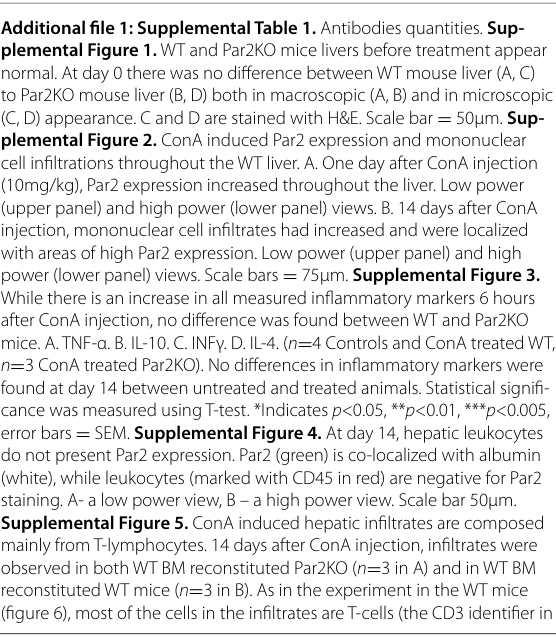
SEM. Supplemental Figure 4. At day 14, hepatic leukocytes = do not present Par2 expression. Par2 (green) is co-localized with albumin (white), while leukocytes (marked with CD45 in red) are negative for Par2 staining. A- a low power view, B – a high power view. Scale bar 50μm. Supplemental Figure 5. ConA induced hepatic infiltrates are composed mainly from T-lymphocytes. 14 days after ConA injection, infiltrates were observed in both WT BM reconstituted Par2KO ( n 3 in A) and in WT BM = reconstituted WT mice ( n 3 in B). As in the experiment in the WT mice = (figure 6), most of the cells in the infiltrates are T-cells (the CD3 identifier in